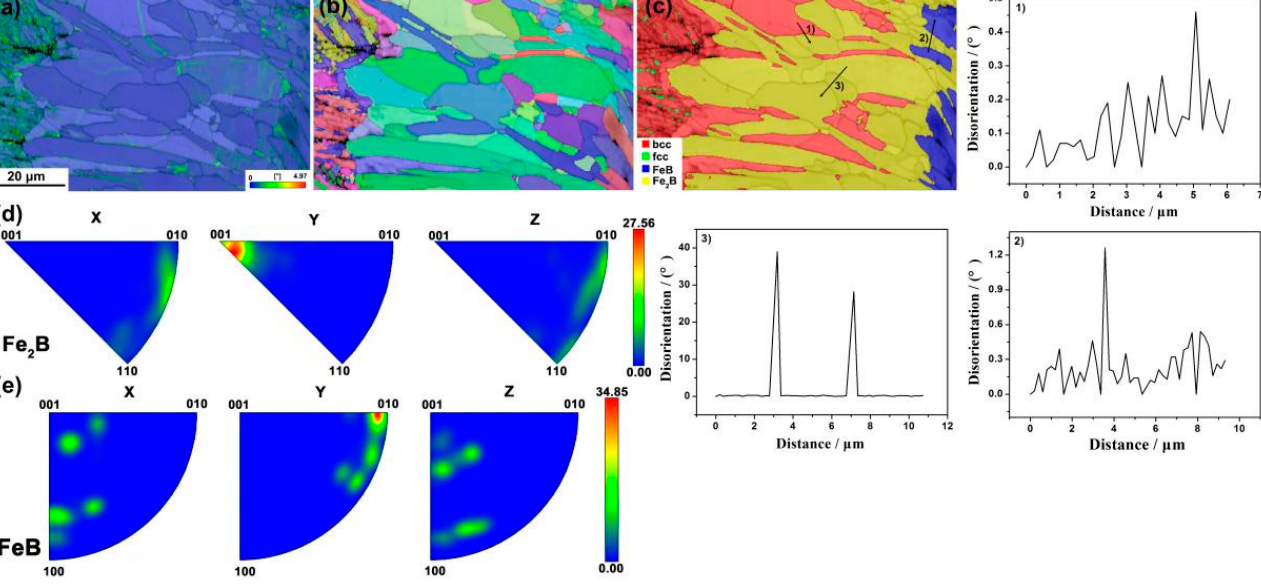
Figure 7. Map scanning of elements along the depth of the produced layer from the surface of sam- ple BA-8: ( a ) origin image; ( b ) distribution of C content; ( c ) distribution of B content; ( d ) distribution of Si content. 3.2. Evaluation of Adhesion Strength and Hardness Profiles